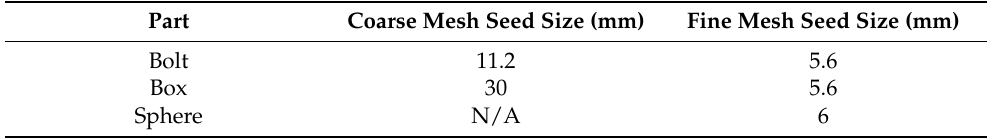
Table 12. Calibrated model mesh